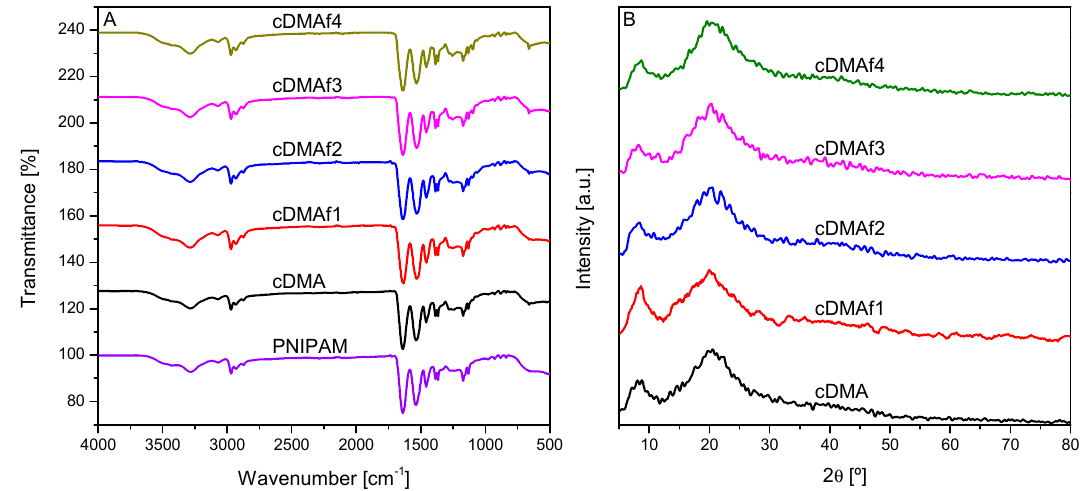
Figure 1. Microstructural features of the resulting materials characterized by Fourier transform infrared (FTIR) spectroscopy ( A ) and X-ray powder diffraction ( B ).